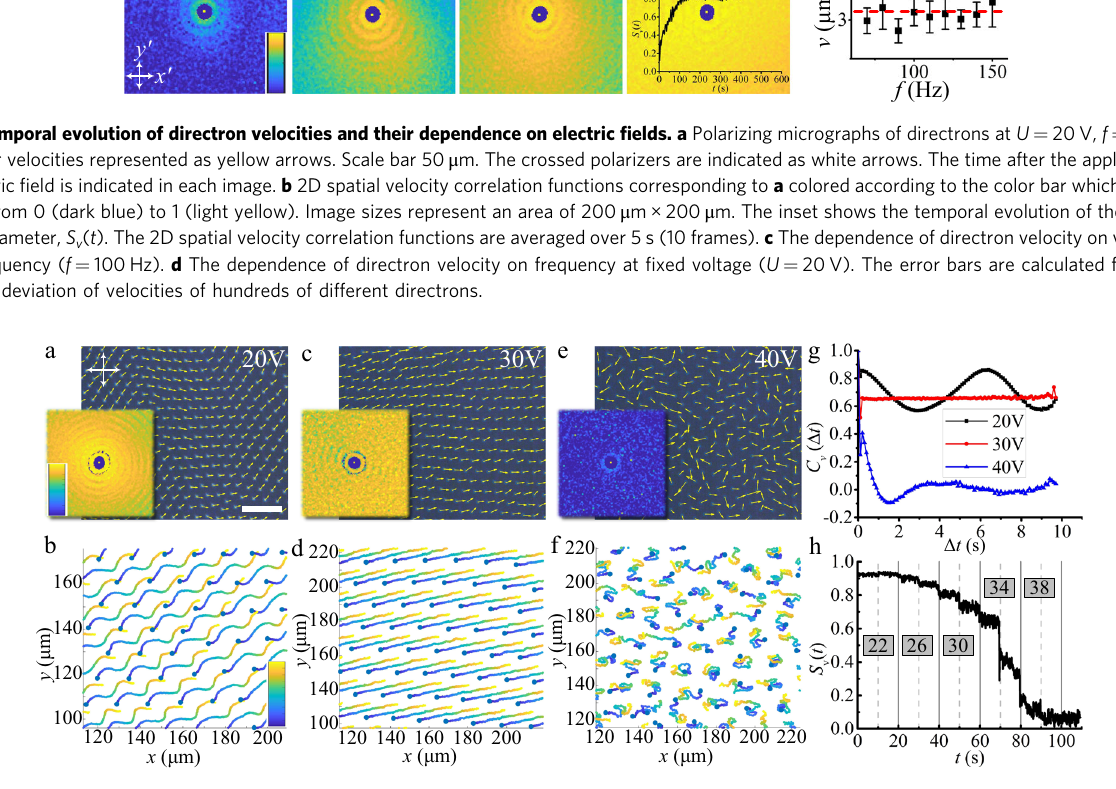
Fig. 7 Voltage dependence of collective motion. Polarizing micrographs of directrons at ( a ) U = 20 V, ( c ) U = 30 V, and ( e ) U = 40 V, respectively, with their velocities represented as yellow arrows. The frequency is fi xed at f = 100 Hz. Scale bar 50 μ m. The crossed polarizers are indicated as white arrows. The insets are the corresponding 2D spatial velocity correlation functions colored according to the color bar which changes linearly from 0 (dark blue) to 1 (light yellow). The image sizes represent an area of 200 μ m × 200 μ m. The 2D spatial velocity correlation functions are averaged over 10 s (20 frames). Trajectories of directrons at ( b ) U = 20 V, ( d ) U = 30 V, and ( f ) U = 40 V, respectively, colored with time corresponding to the color bar, which changes linearly from t = 0 s (dark blue) to t = 10 s (light yellow). g The temporal velocity correlation functions ( C v ( Δ t )) of directrons at different voltages corresponding to a , c , and e . h Time dependence of the velocity order parameter, S v , with the applied voltage (indicated as numbers in gray squares) gradually increasing from 20 V to 40 V in a step of 2 V every 10 dependent on the cutoff size 52,53 . If the cutoff size is small, the exponential decay will be the only part of the functionality, but if the cutoff size is large, one may predict that the group size dis- tribution would better fi t a power law 52,53 . We plot the size dis- tribution of directron fl ocks on a log-log scale and fi nd a cutoff size of n = 4 (Fig. 4b bottom).